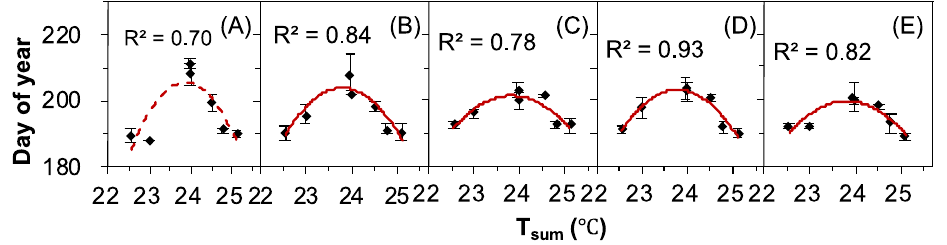
Figure 4. Correlations between the onset of seed release (OSR) and summer mean temperature (T sum ) in Nitraria tangutorum . ( A ) Ctrl, ( B ) +25%, ( C ) +50%, ( D ) +75%, and ( E ) +100% water addition treatments. The solid lines indicate p ≤ 0.05, while the dashed line indicates 0.05 ≤ p ≤ 0.1. Unlike OSR, ESR was not correlated to T sum , but it significantly correlated with cumulative summer precipitation (P sum ) under all treatments (control, +25%, +50%, +75%, and +100%), with upward quadratic relationships (all p ≤ 0.05, Figure 5, Table 2). Similarly, there was no significant correlation between ESR and other meteorological factors (Table